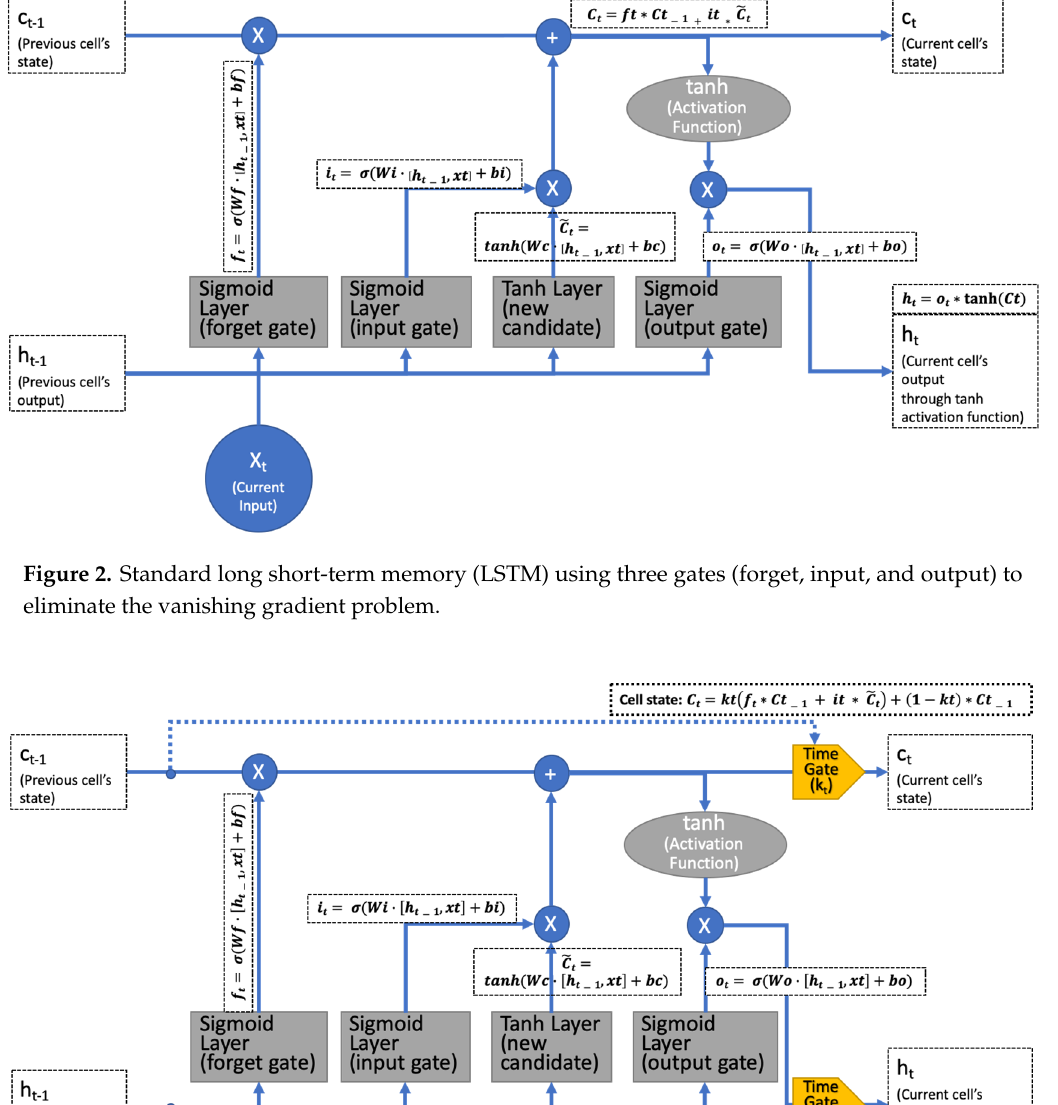
Figure 2. Standard long short-term memory (LSTM) using three gates (forget, input, and output) to eliminate the vanishing gradient problem.